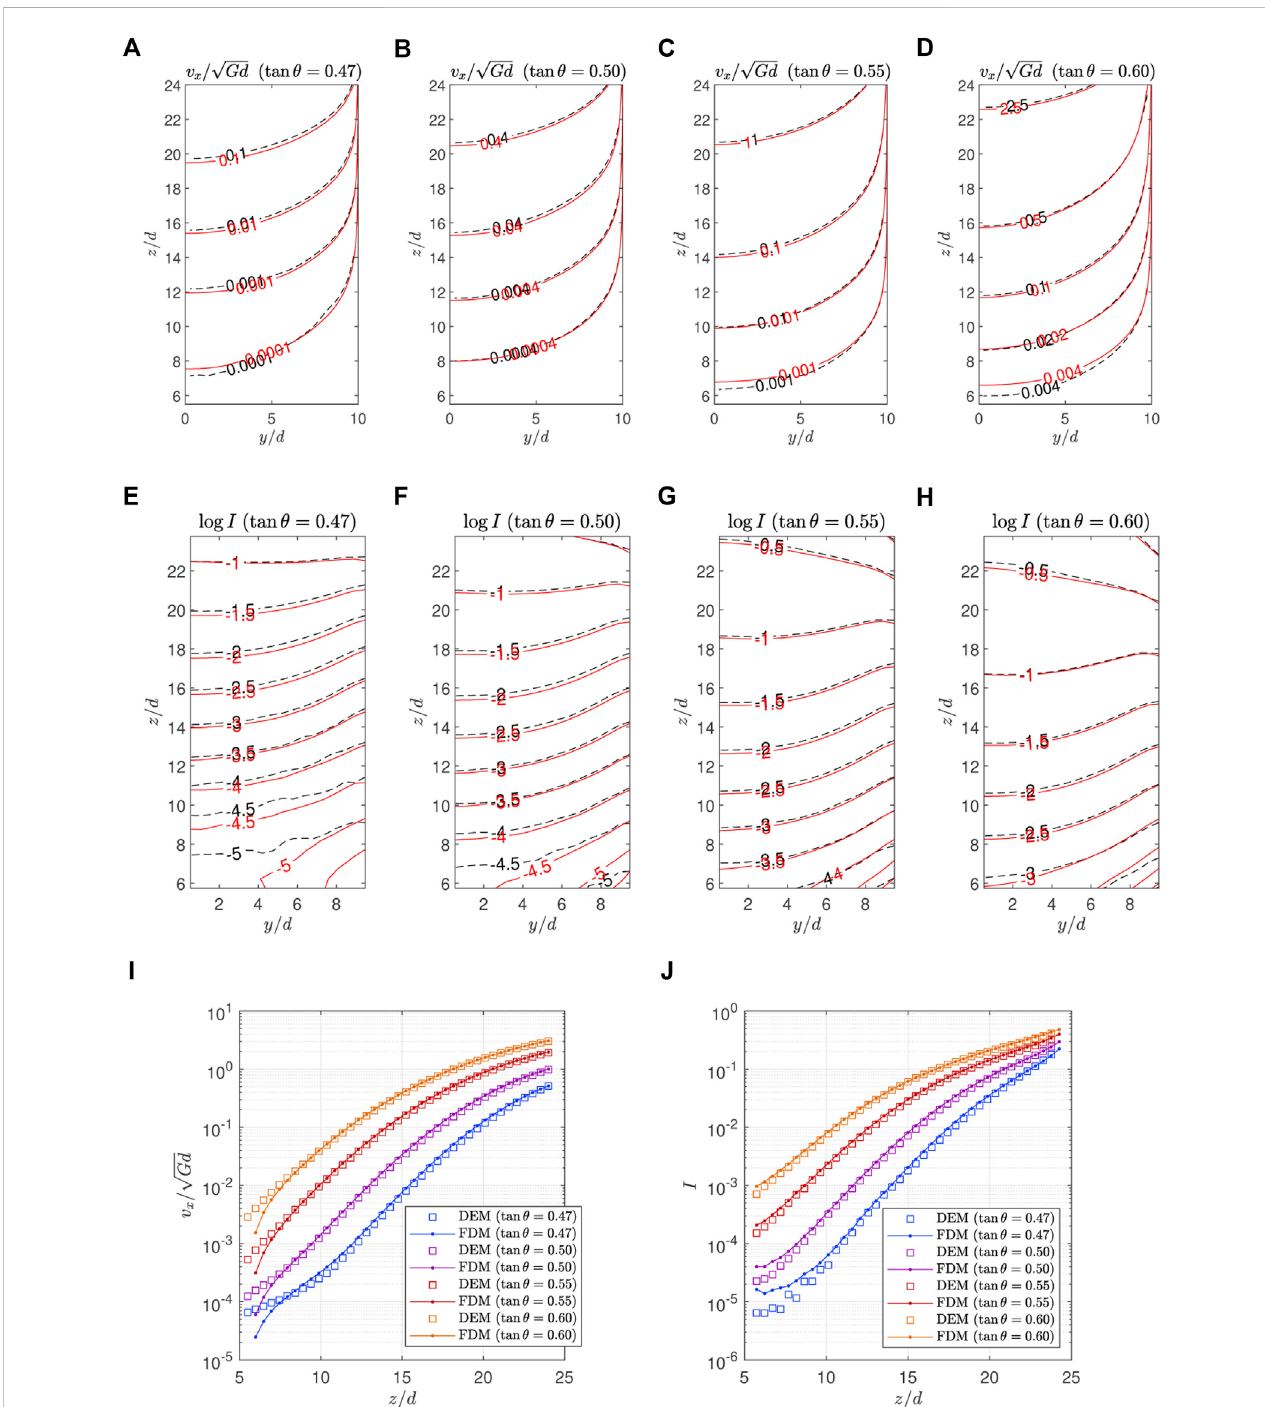
FIGURE 12 (cid:1)(cid:1)(cid:1) √ Gd Comparison of (A – D) v x / and (E – H) log I contours between the DEM simulations (black dashed lines) and the FDM simulations using the second- order model (red lines) for different inclination angles: (A, E) tan θ = 0.47, (B, F) tan θ = 0.50, (C, G) tan θ = 0.55, and (D, H) tan θ = 0.60. (I) v x / pro fi les of the DEM simulations (squares) and the FDM predictions (lines) at the center plane ( y =